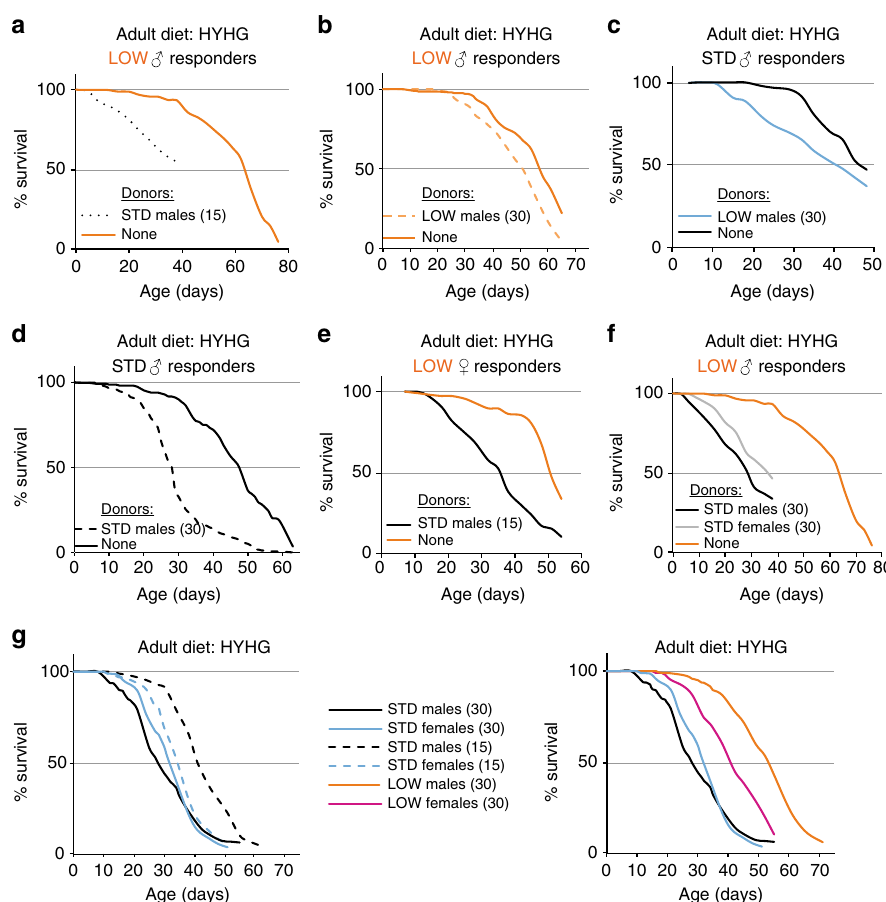
Fig. 4 STD and LOW fl ies of both sexes produce and respond to autotoxins. a , b Survival of LOW iso31 responder males is decreased more by vials preconditioned with 15 STD a than with an equivalent biomass of 30 LOW b males. Survival curves shown in b are a subset of those shown in Fig. 3f and are repeated here to facilitate side-by-side comparisons with the data in a . c Survival of STD responder males (10 per vial) in vials preconditioned with 30 LOW males. d Survival of STD responder males (15 per vial) in vials preconditioned with 30 STD males. e Survival of LOW responder females (15 per vial) in vials preconditioned with 15 STD males. f Survival of LOW responder males (15 per vial) in vials preconditioned with 30 STD males or 30 STD females. g The tendency of females to survive longer than males is reversed by housing adults at a lower density (15 per vial; left graph) or by a LOW developmental dietary history (right graph). All graphs use HYHG adult diet and show a survival curve with non-preconditioned control vials (none). To aid comparison, and as the experiments were performed in parallel, the curves with no donors (none) are the same in a , f and the curves for STD males and females (30 per vial) are also the same in both graphs in